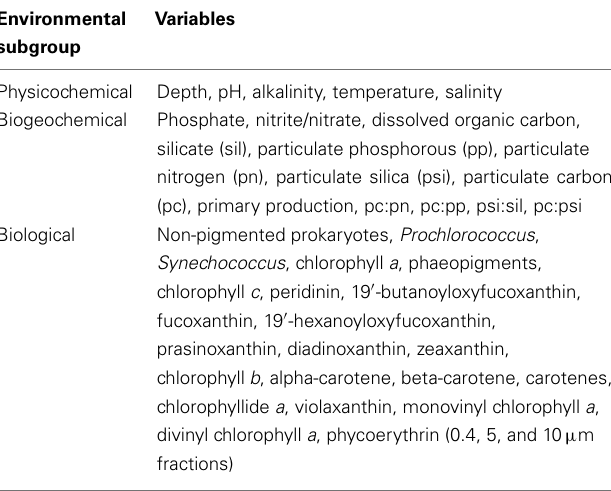
TableA3 | Spearman rank correlation between environmental variables and